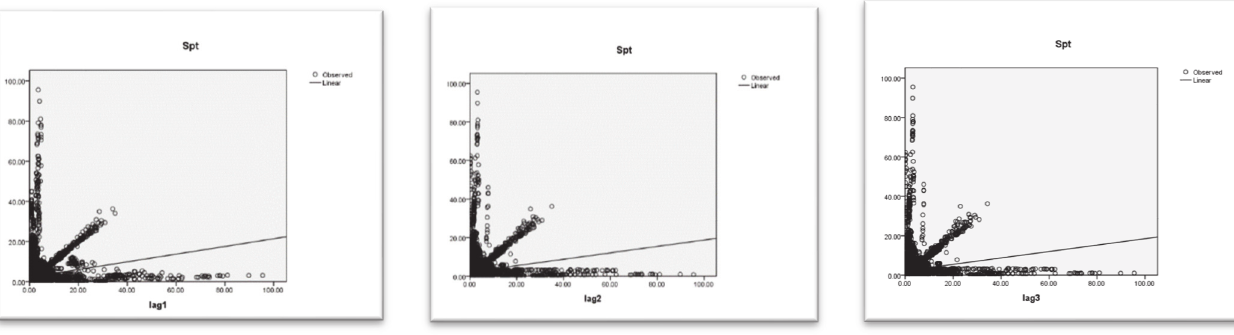
Fig. 1. The patterns of stock price in lag1, lag2 and